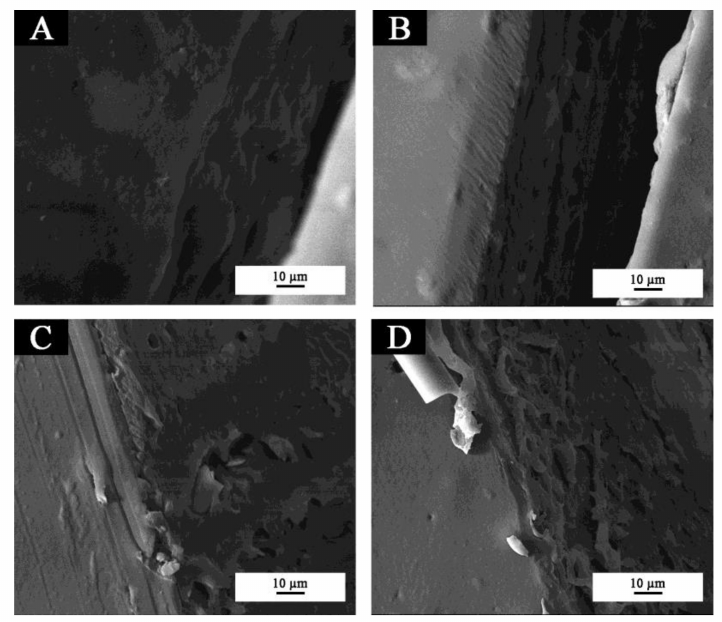
Figure 5. Cross-sectional SEM micrographs. ( A – D ) thermochromic waterborne coating with the PVC of glass fiber powder of 0, 4.0%, 16.0%, and 30.0%.